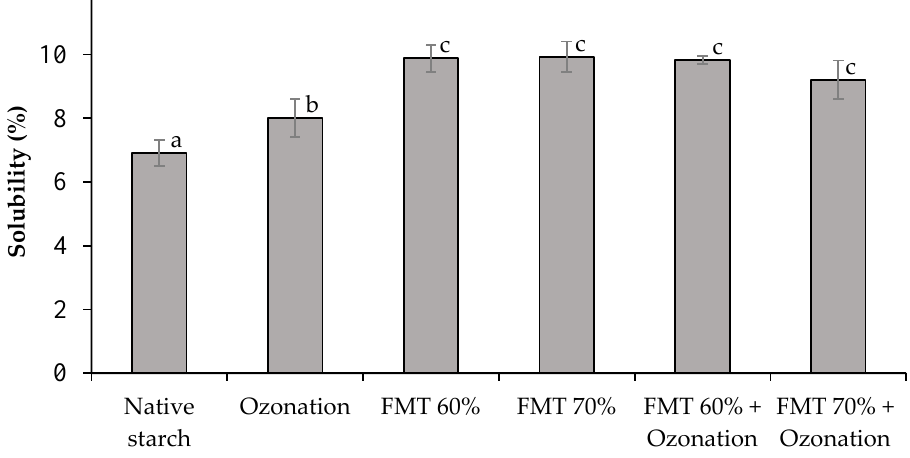
Figure 2. The solubility of native adlay starch and adlay starch modified by FMT and ozonation. Different letters show significant differences between treatments ( p < 0.05).